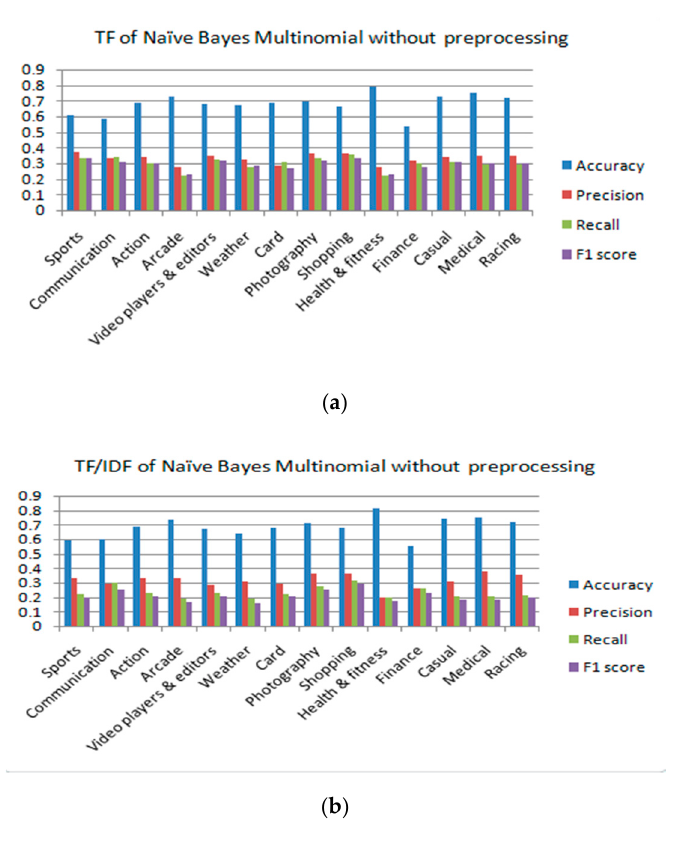
Figure 8. ( a ) Bar-chart visualization of TF naïve Bayes multinomial algorithm based without preprocessing of data; ( b ) bar-chart visualization of TF / IDF naïve Bayes multinomial algorithm based without preprocessing of data.